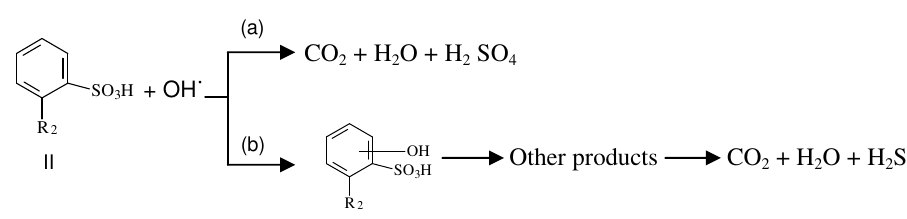
Figure 4 . The degradation route of the segment (II).